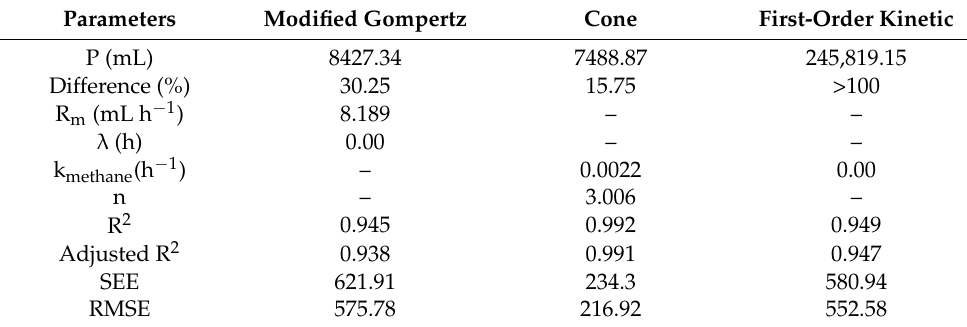
Table 3. Kinetic models applied to methane production from dry AD of